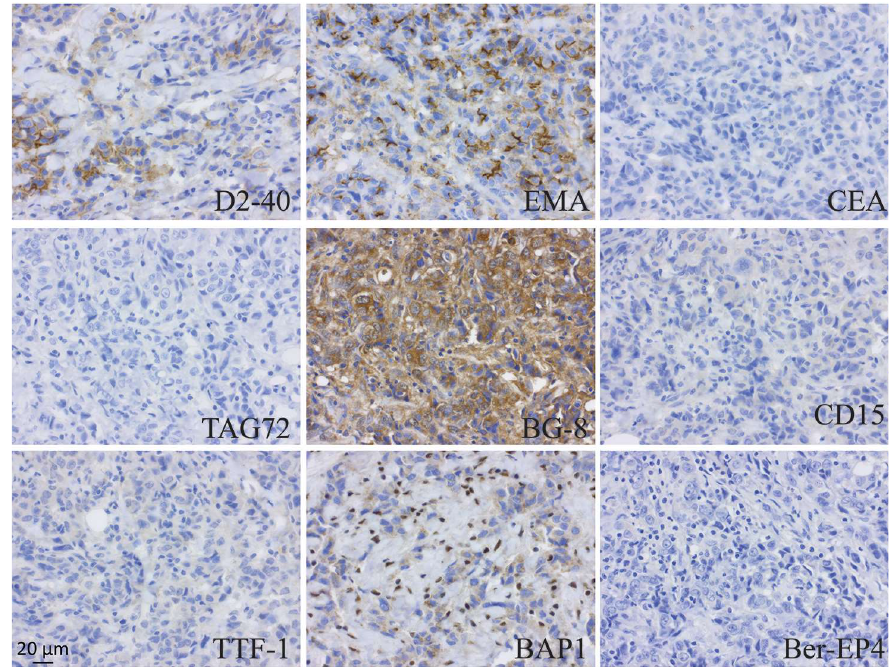
Figure 1. Representative immunohistochemical (IHC) staining of a malignant pleural mesothelioma (MPM) (sample ID 1157) patient tumor sample with the 15 biomarkers currently used for clinical diagnosis. BAP1 is not expressed in sample MM ID 1157, therefore BAP1 staining of sample MM ID 1518 is included as an example of positive BAP1 expression in this figure. All pictures are taken at same magnification with scale bar indicated left bottom corner of TFF-1 staining.